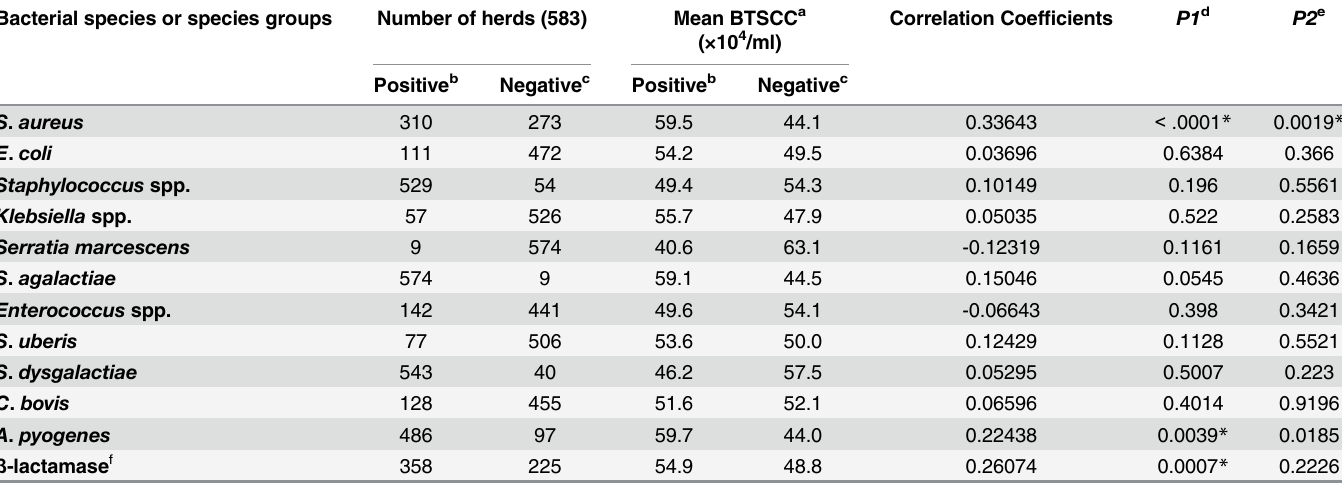
Table 2. Correlations between the presence of mastitis pathogens and the mean bulk tank milk somatic cell counts, and differences in bulk tank milk somatic cell counts between the mastitis pathogens positive and negative herds. Bacterial species or species groups Number of herds